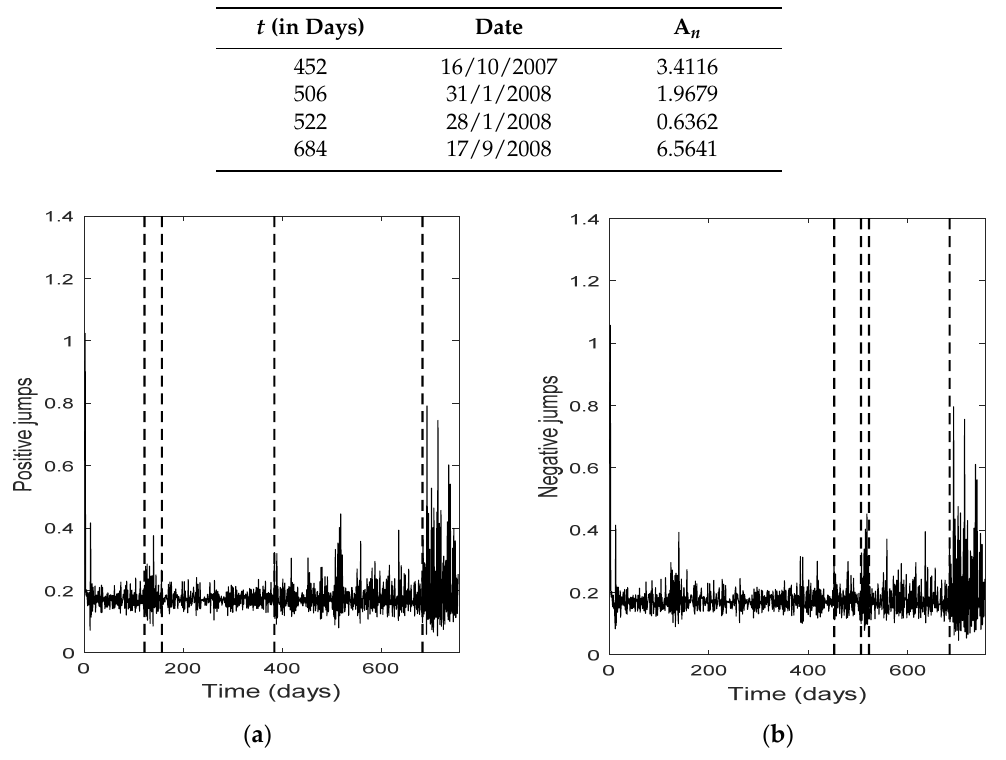
Figure 7. ( a ) Change points for the estimated positive jumps of Intel; ( b ) Change points for the estimated negative jumps of Intel. Table 17. Change points for Microsoft with the corresponding test statistic value.